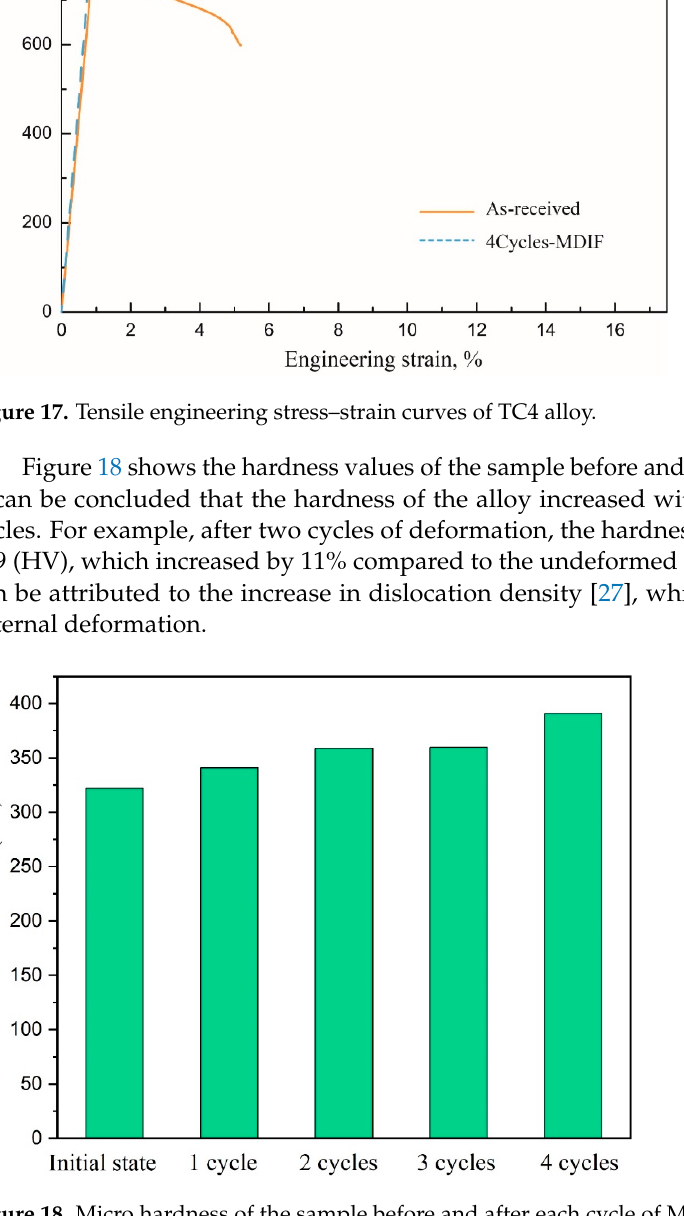
Figure 18. Micro hardness of the sample before and after each cycle of MDIF.